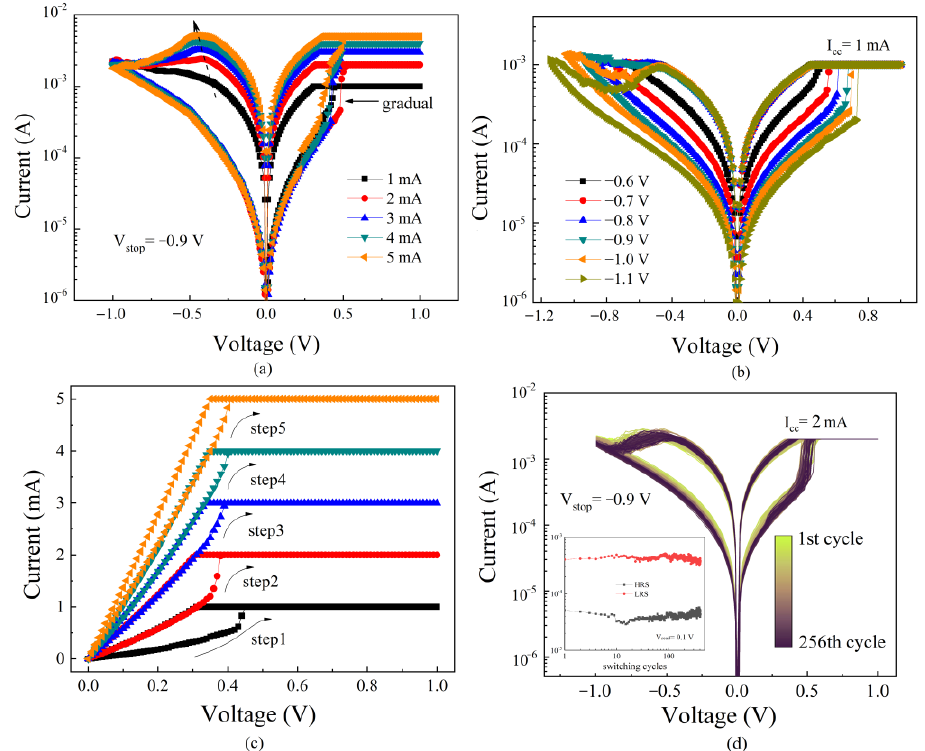
Figure 2. Typical DC I-V bipolar switching curves of Al-doped HfO 2 -based RRAM devices. The multi-level states in this measurement are achieved by varying ( a ) the set compliance current and ( b ) the reset stop voltages. ( c ) The DC I-V characteristic curve of the device during gradually increasing compliance current in the set process. ( d ) I-V characteristics of the first 256 DC sweep; the illustration shows the cycling endurance. The current compliance was applied to protect the devices from permanent breakdown during testing.